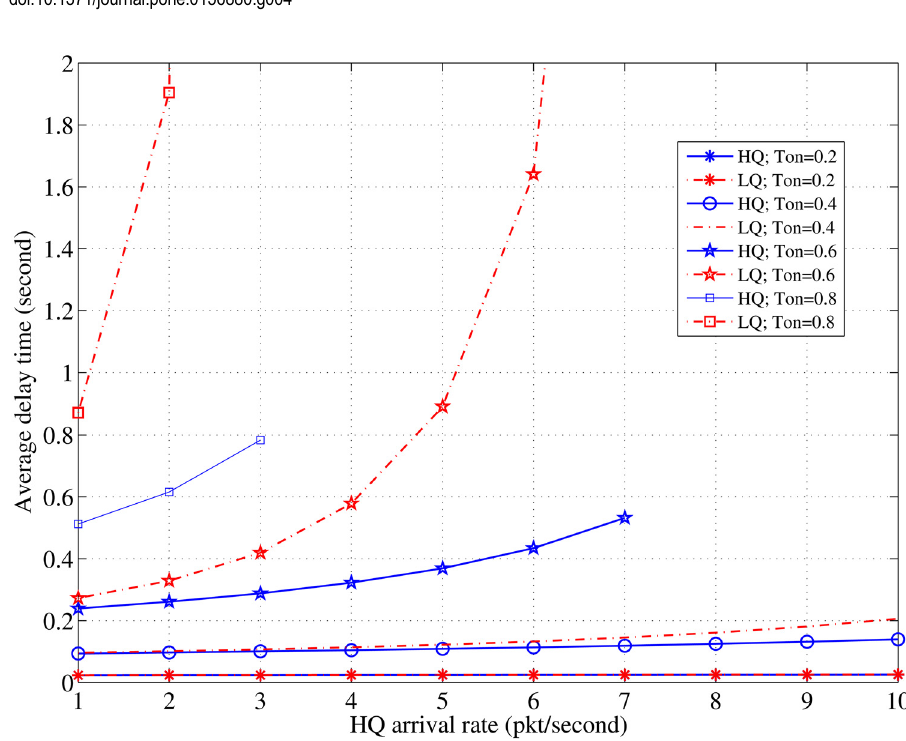
Fig 5. Relationship between λ HQ and the delay in case of various values of τ off ; N = 10, λ LQ = 3